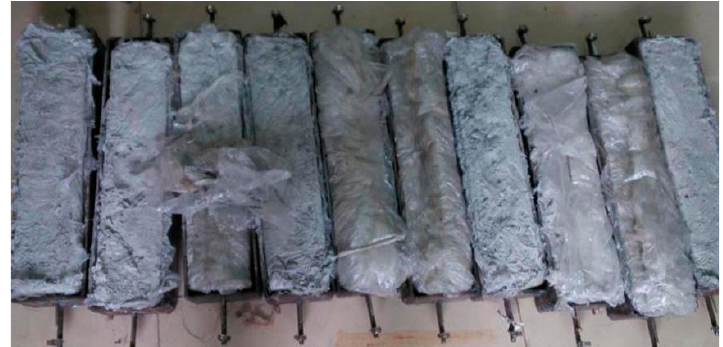
Figure 6. Schematic diagram of the free shrinkage test.